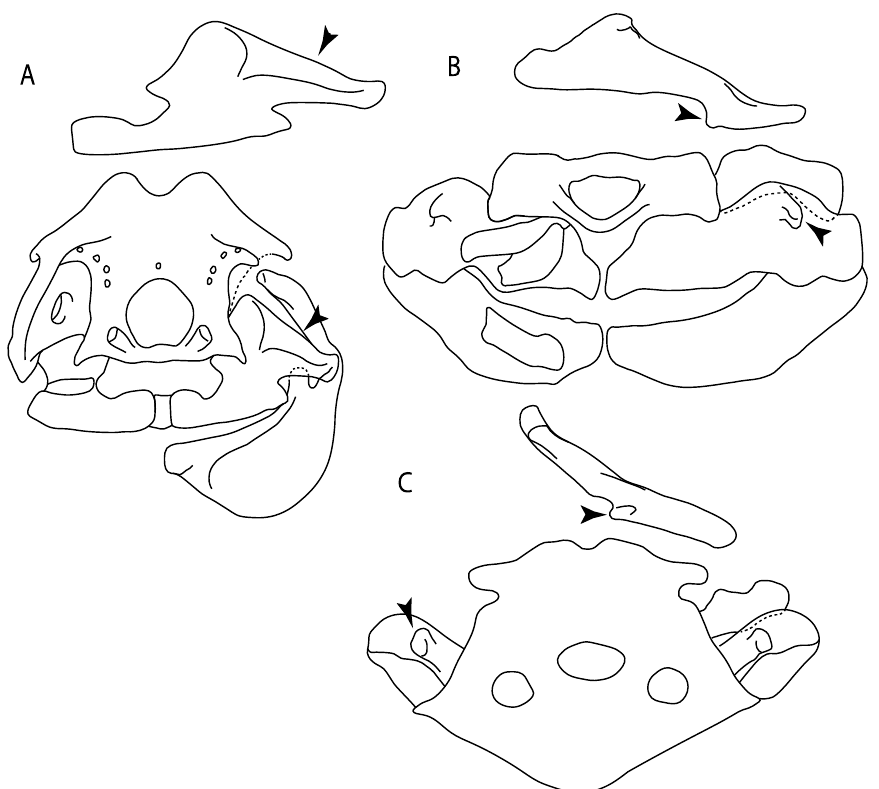
Figure 24. Interpretative drawings of neurocranium and dorso-frontal view of left antimere of palatoquadrate. State (1): ( A ) † Egertonodus († Hybodus) basanus redrawn and modified from Maisey Text-Figure 3 in [98]; ( B ) Squatina nebulosa (AMNH 258172, https://sharksrays.org/ (accessed on 5 May 2020)); ( C ) Pristiophorus nudipinnis (CSIRO 3731, https://sharksrays.org/ (accessed on 5 May 2020)) Arrowheads: Quadrate flange (quadrate process).